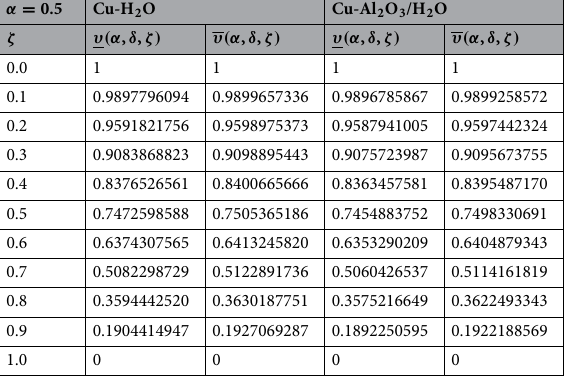
Table 8. Fuzzy velocity distribution of lower and upper bound in diverging channel when various values of ζ and α = 0.5, Ha = 500, Re = 15, ω = 3 0 .